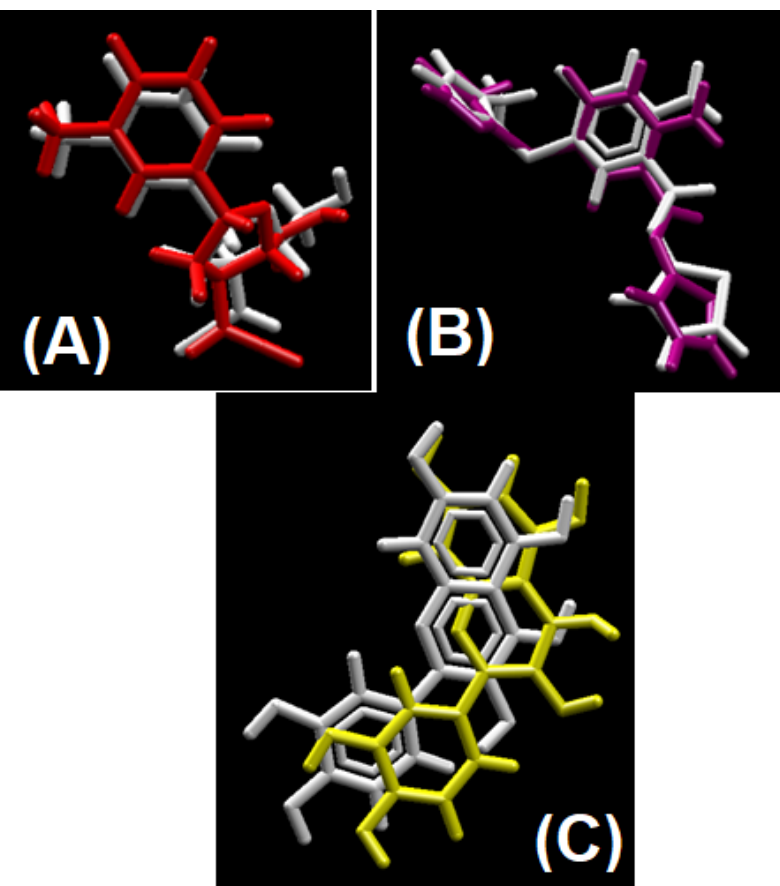
Figure 13. Validation of docking protocol by superimposing native ligand to redocked ligand to their respective co-crystal structure. ( A ) Redocked ligand (red) superimpose to native ligand (white) for anti-cancer docking protocol validation; ( B ) redocked ligand (purple) superimpose to native ligand (white) for anti-diabetic docking protocol validation; ( C ) redocked ligand (yellow) superimpose to native ligand (white) for antioxidant docking protocol validation.